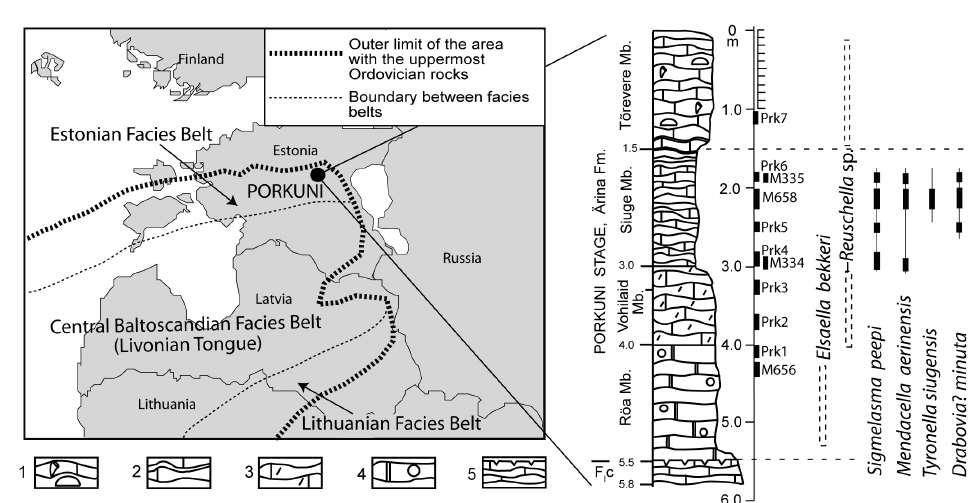
Fig. 1. Locality map with facies belts, log of the Porkuni old quarry section (modified from Hints et al. 2000) and distribution of the studied brachiopods. The levels of the studied samples processed by P. M(cid:228)nnik for conodonts (Prk1(cid:150)7 and M656, M334, M658, M335) are shown on the right side of the log. The rectangle marked by the dashed line denotes the distribution of the brachiopod on the level of the member. Legend for the log: 1, stromatoporoid-coral reef limestone; 2, bituminous limestone; 3, skeletal grainstone; 4, dolomite with crinoid ossicles; 5, argillaceous dolomite with discontinuity surface. F I c (cid:150) Pirgu